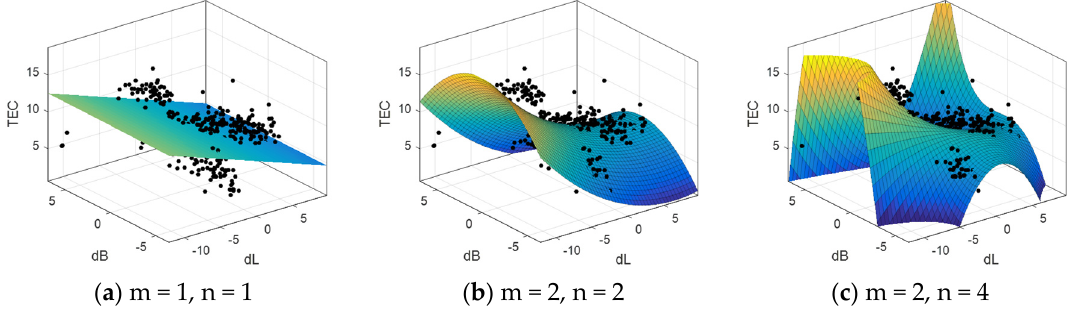
Figure 10. Ionospheric total electron content (TEC) modeling with different degree of polynomial.